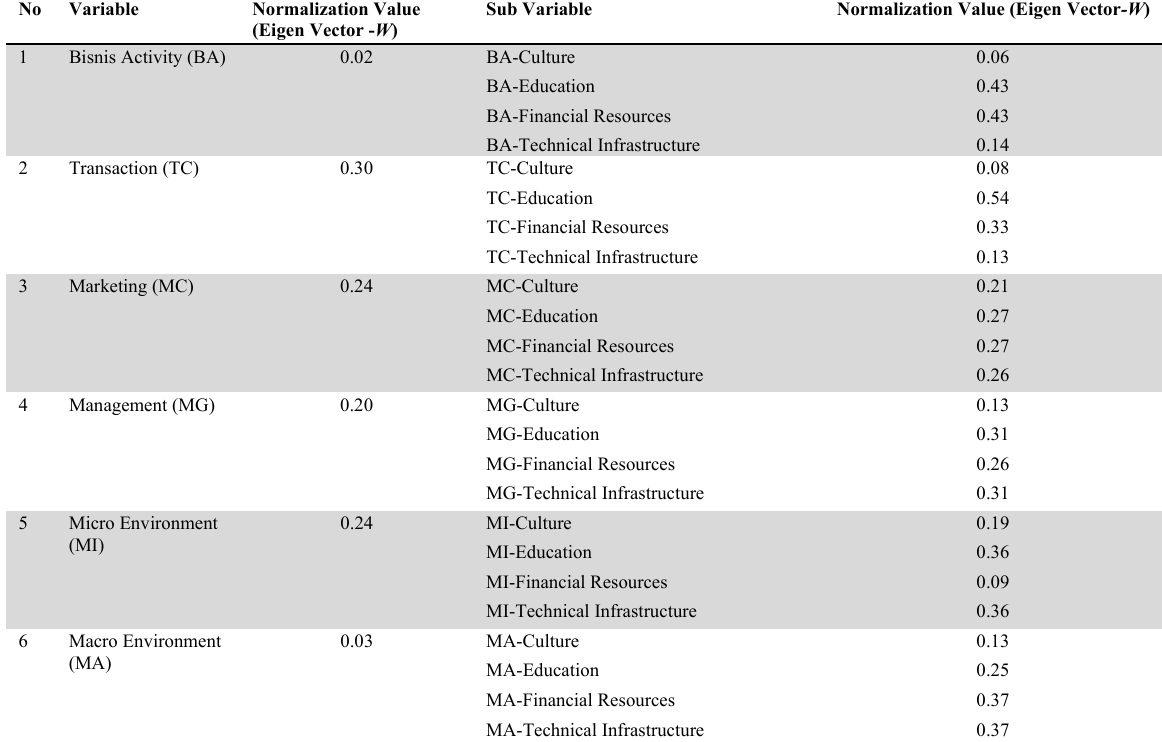
Table 3. Herein, the significant values of fuzzy operation are described the different priorities in more detail. Table 4 The recapitulation of F-AHP priority weighted values ( W